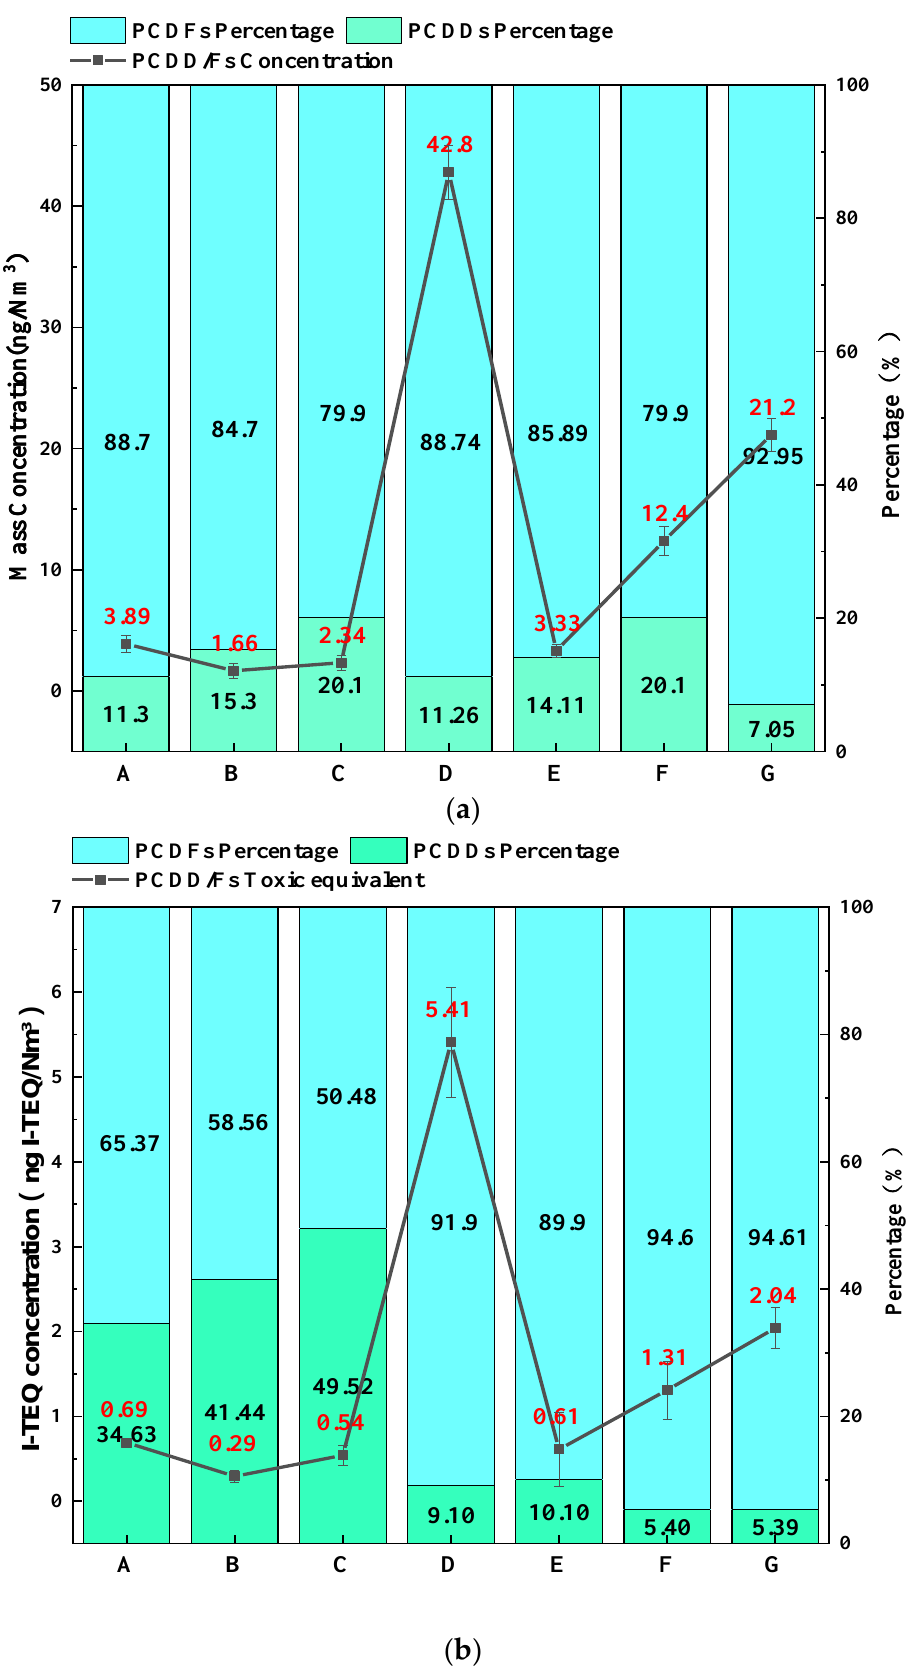
Figure 5. Concentration of PCDD/Fs in flue gas. ( a ) Concentration of dioxin in flue gas; ( b ) toxic equivalent of dioxin in flue gas.